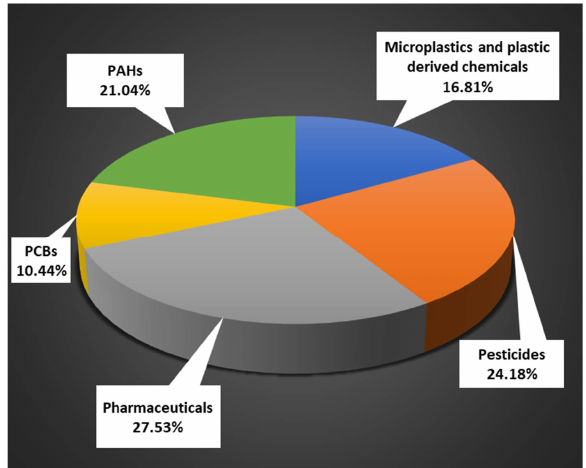
Figure 2. Overall relative frequency of reports of different chemical groups of POPs overviewed in present review regarding the evaluation of their potential toxicity on marine biota. The plotted data were obtained from “Scopus”, “Google Scholar”, “SpringerLink”, and “Open Access Journal Search Engine”. Overall means all kinds of data including research article, review, short notes, editorial commentary, research articles, books and book chapters, etc., that were published from 01/01/2016 to 30/06/ 2021. Target pollutants were tested either individually or in mixture with other contami- nants.